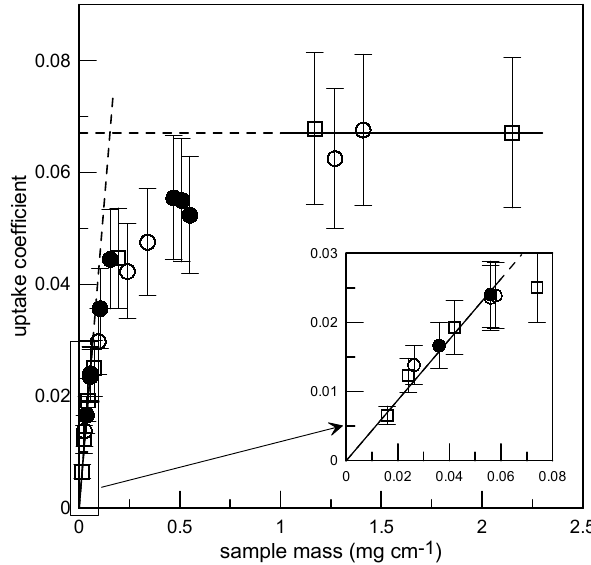
Fig. 4. Dependence of the uptake coefficients of HO 2 (calculated using geometric surface area) on mass of ATD samples (per 1cm length of the support tube): T = 300K, P = 1Torr, dry conditions, [HO 2 ] 0 ≈ 10 12 moleculecm − 3 . Circles and squares correspond to the results obtained using F + H 2 O 2 and Cl + CH 3 OH + O 2 sys- tems to produce HO 2 ; filled and open symbols represent the data observed with HO 2 detection at m/z = 96 (HOBr + ) and 46 (NO +